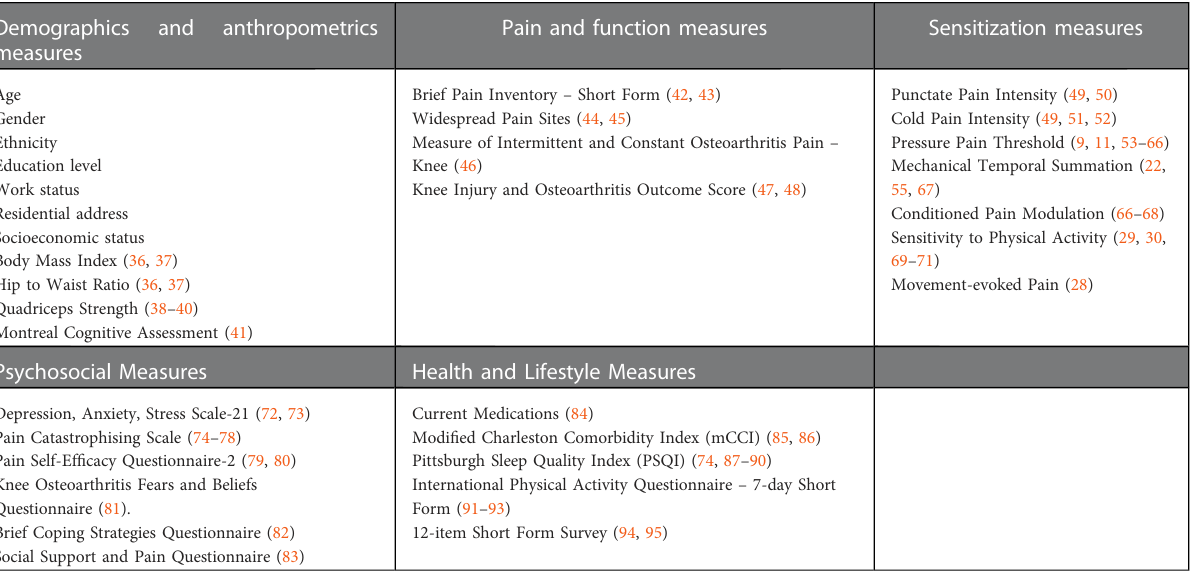
TABLE 1 Baseline assessment